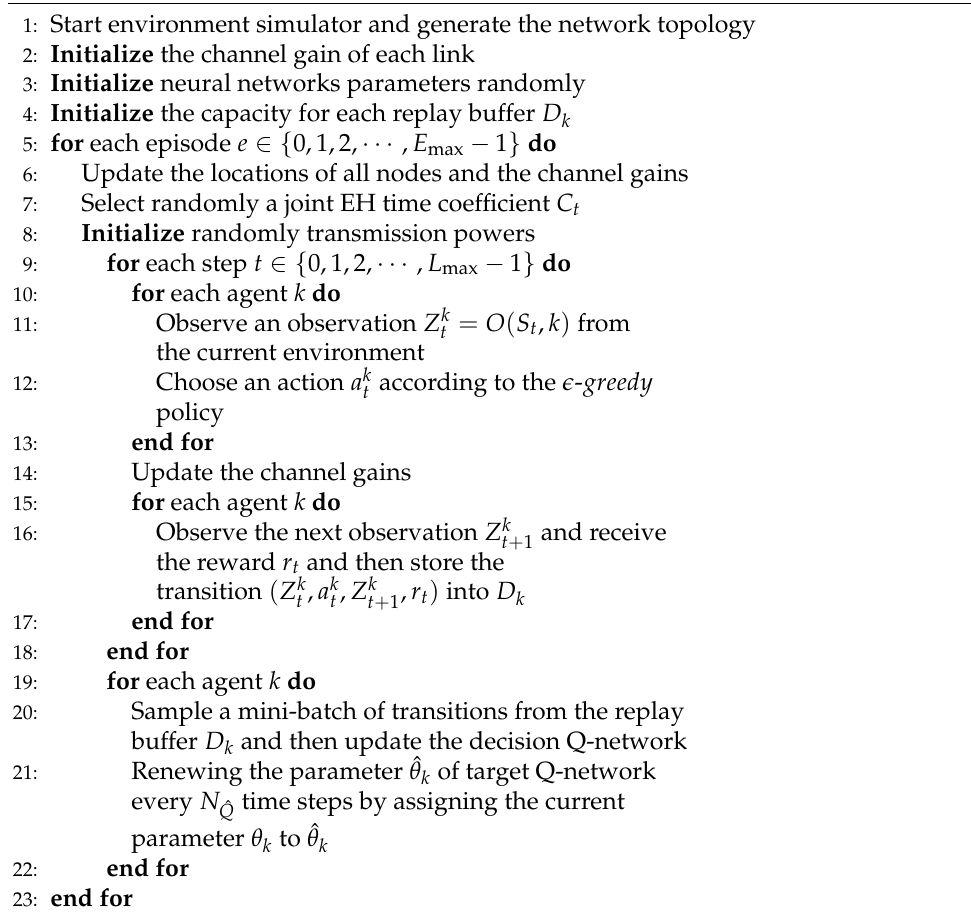
Algorithm 1 LSTM-D3QN with prioritized experience